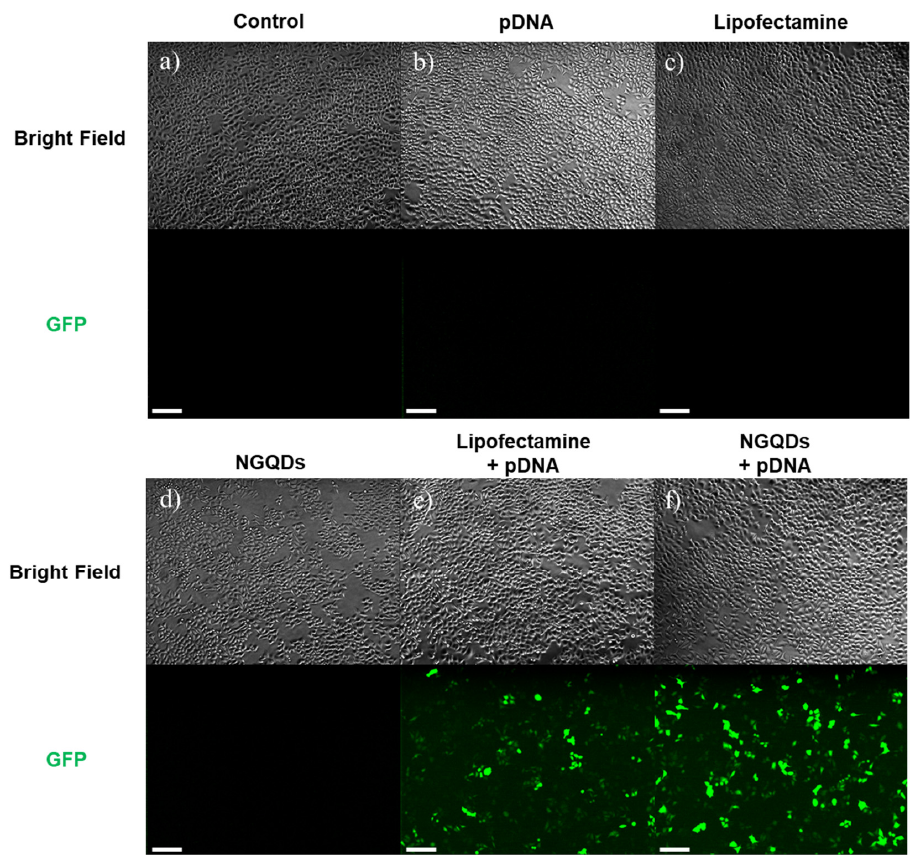
Figure 7. Fluorescence microscopy images of HeLa cells after 24 h transfection with ( a ) control, ( b ) pDNA only, ( c ) Lipofectamine only, ( d ) NGQDs only, ( e ) Lipofectamine + pDNA complex, and ( f ) NGQDs + pDNA complex. All scale bars are 200 µ m.